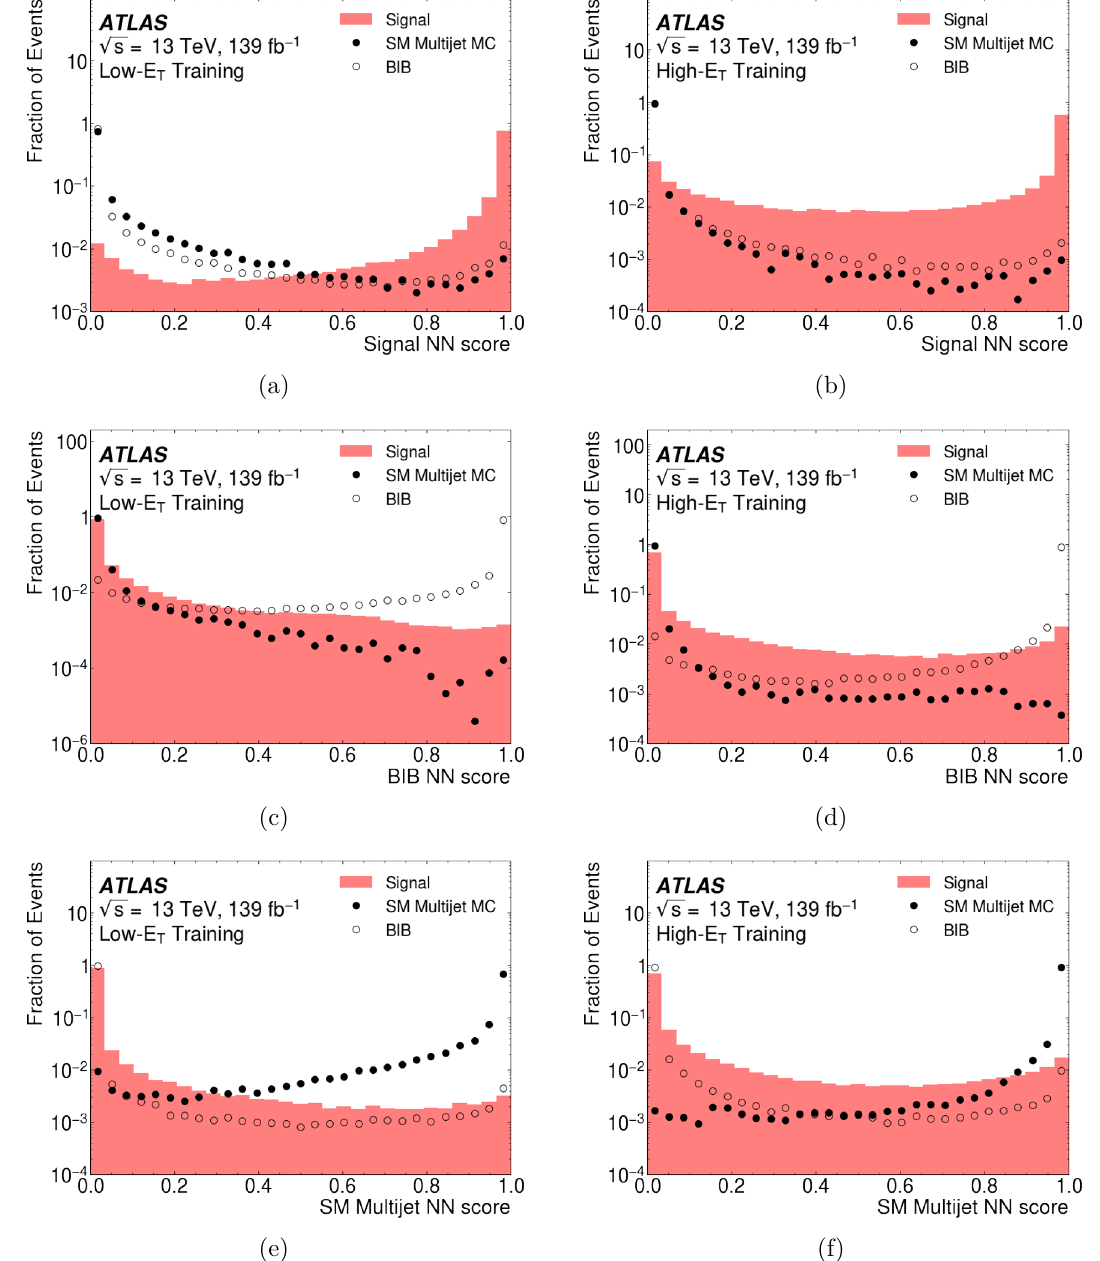
Figure 6. The NN output scores for (a,b) signal, (c,d) BIB and (e,f) SM multijets shown for low- E T and high- E T training. The jets used here are part of the validation set, and follow the selection used when choosing jets to train the NN in signal, multijets and